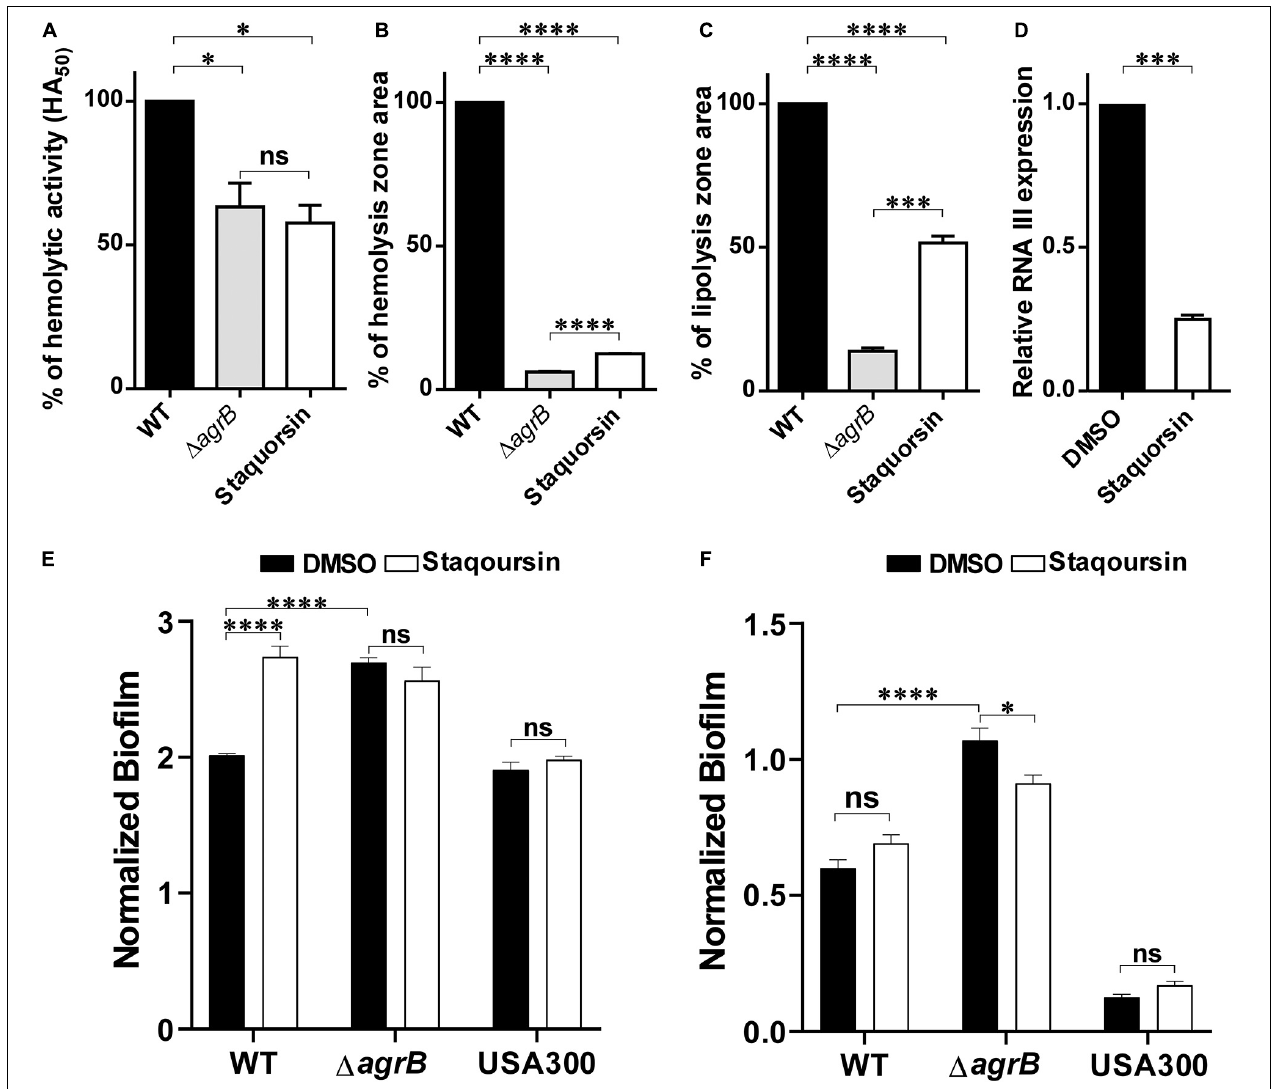
FIGURE 2 | Staquorsin antagonizes the Agr system phenotypically and on the molecular level. The effect of staquorsin on some phenotypic Agr-related virulence activities (A) The alpha-hemolysin activity on rabbit RBCs as measured by the HA 50 values. The HA 50 of culture supernatants of cells grown in the presence of 40 µ M staquorsin is presented as percentage of that of the WT grown in the absence of staquorsin. (B) The delta-hemolysin activity on sheep RBCs as measured by the area of the hemolysis zone. The area of the hemolysis zone produced by culture supernatants of cells grown in the presence of 200 µ M staquorsin is presented as percentage relative to that of the WT grown in the absence of staquorsin. (C) The lipolytic activity as measured by the area of the zone of lipolysis on tributyrin agarose. The area of the lipolysis zone produced by culture supernatants of cells grown in the presence of 200 µ M staquorsin is presented as percentage relative to that of the WT grown in the absence of staquorsin. In all of the above three charts, data of the (cid:49) agrB strain was used as a negative control. Statistical analyses were performed by applying ordinary one-way ANOVA followed by Tukey’s multiple comparisons test. (D) Effect of staquorsin on the transcription of RNA III. The level of the RNA III in cells grown in the presence of 40 µ M staquorsin was assessed and presented relative to the level in cells grown in its absence. Statistical analysis was performed by applying the unpaired t -test. (E) Effect of staquorsin on the biofilm formation. Strains were grown in the presence of either DMSO (black bars) or 40 µ M staquorsin (white bars) and the formed biofilms were assessed by the crystal violet assay. The crystal violet reading at 595 nm was normalized by dividing it by the optical density of the planktonic culture at 600 nm. (F) Effect of staquorsin on the biofilm detachment. Biofilms was formed, then fresh TSB with either DMSO (black bars) or 40 µ M staquorsin (white bars) was added for additional 24 h, then the biofilms were stained was crystal violet and processed as in (E) . Two-way ANOVA was applied followed by Tukey’s multiple comparisons test. In all the above charts, the data presented is the average of three independent experiments, the error bars represent the standard deviation, “ns” indicates non-significant statistical difference ( p- value > 0.05), “ ∗ ” p- value ≤ 0.05, “ ∗∗∗ ” p- value ≤ 0.001, and “ ∗∗∗∗ ” p- value ≤